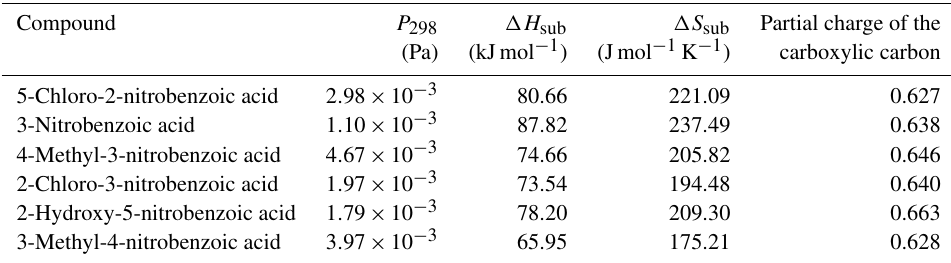
Table 6. P sat at 298K, enthalpies and entropies of sublimation, and partial charge of the carboxylic carbon of nitrobenzoic acids determined S using